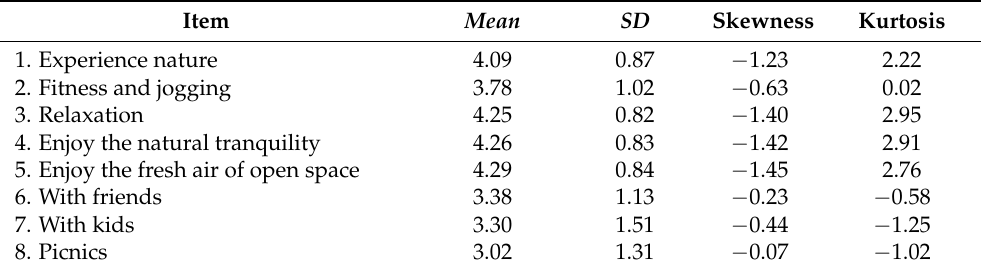
Table A8. Descriptive analysis of leisure motivations ( n = 595, 2021 sample).